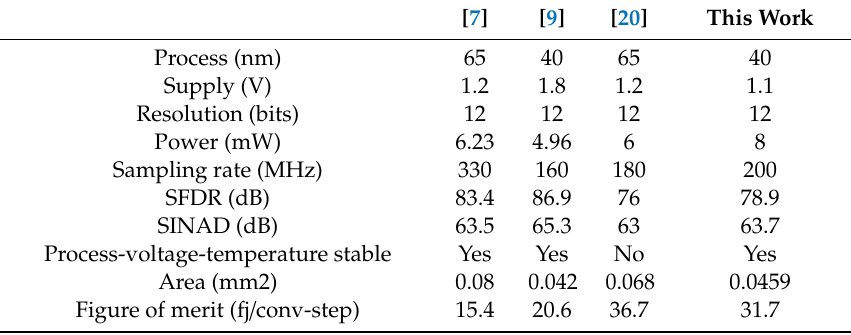
Table 1. Performance of the proposed ADC and comparison with previous